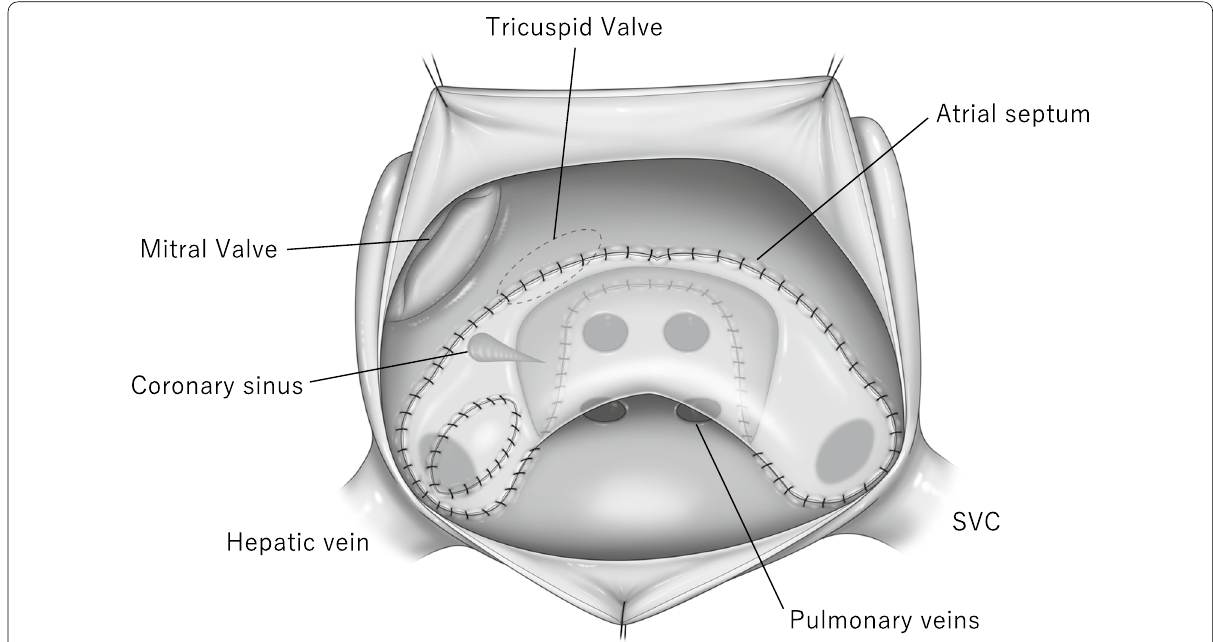
Fig. 2 Surgical schema of intra-atrial baffle repair viewed through a left-sided